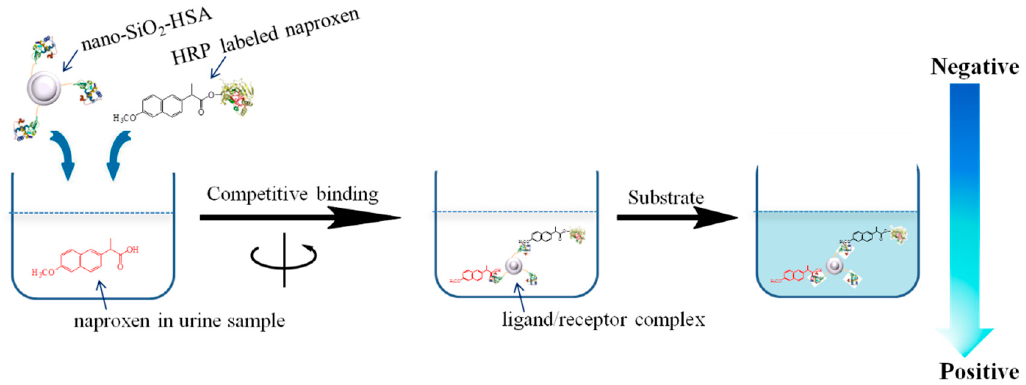
Figure 1. Illustration of naproxen determination by nano-competitive protein binding assay (CPBA).